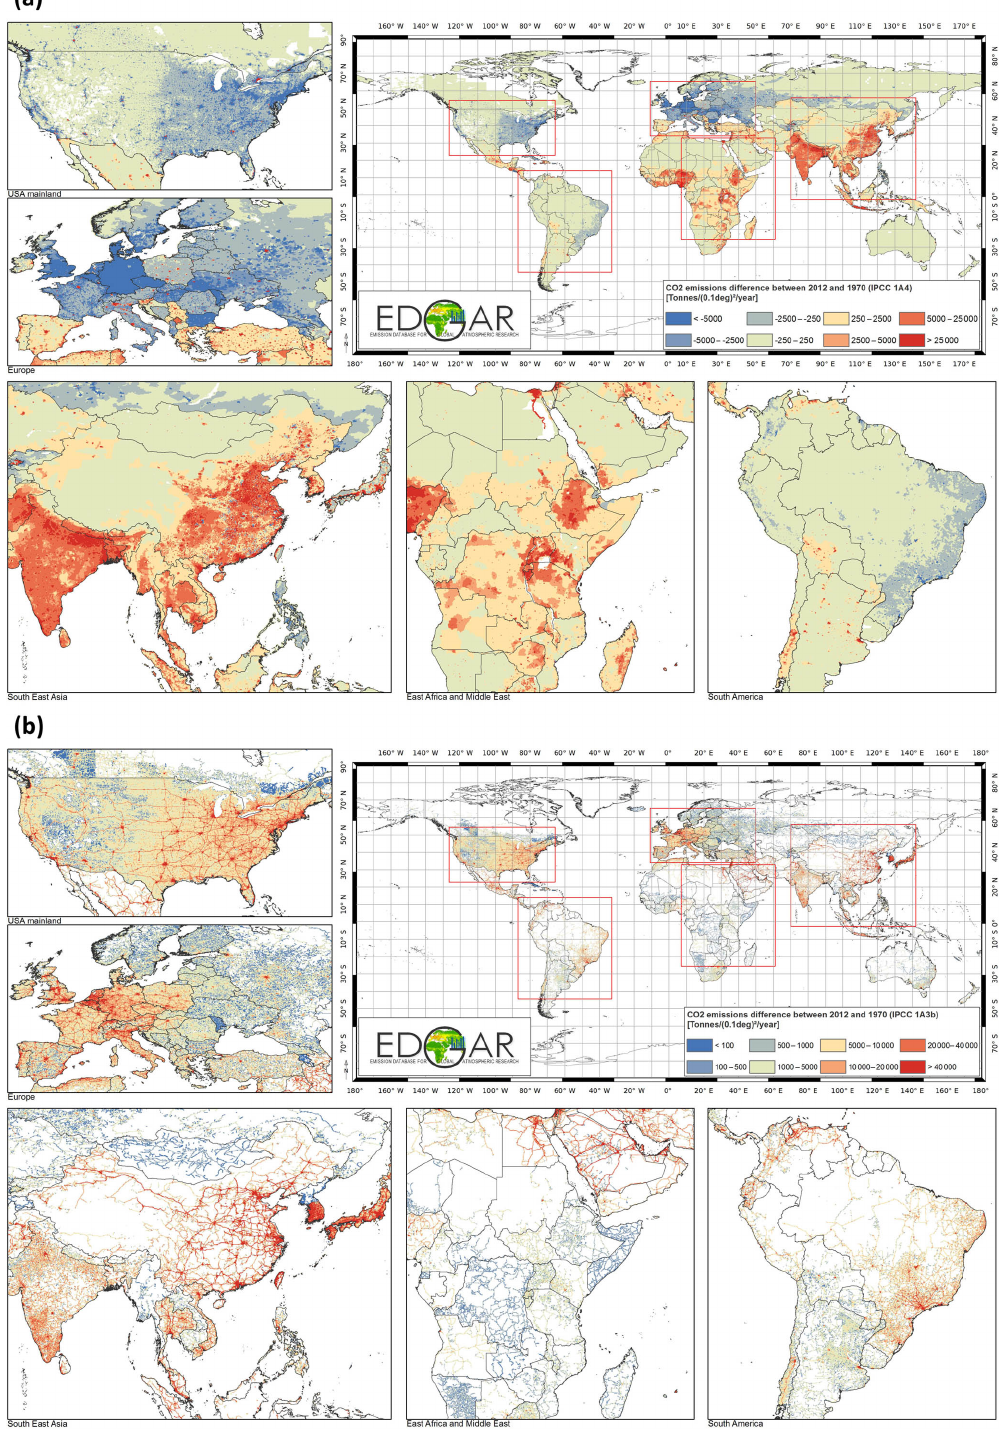
Figure 11. (a) Difference in CO 2 emissions from buildings between 2012 and 1970. The represented CO 2 emissions also include those from short-cycle carbon. The figures for the long-cycle and short-cycle carbon separately are taken up in Fig. S5. (b) Difference in CO 2 emissions from transport between 2012 and 1970. The represented CO 2 emissions also include those from short-cycle carbon. The figures for the long-cycle and short-cycle carbon separately are taken up in Fig.